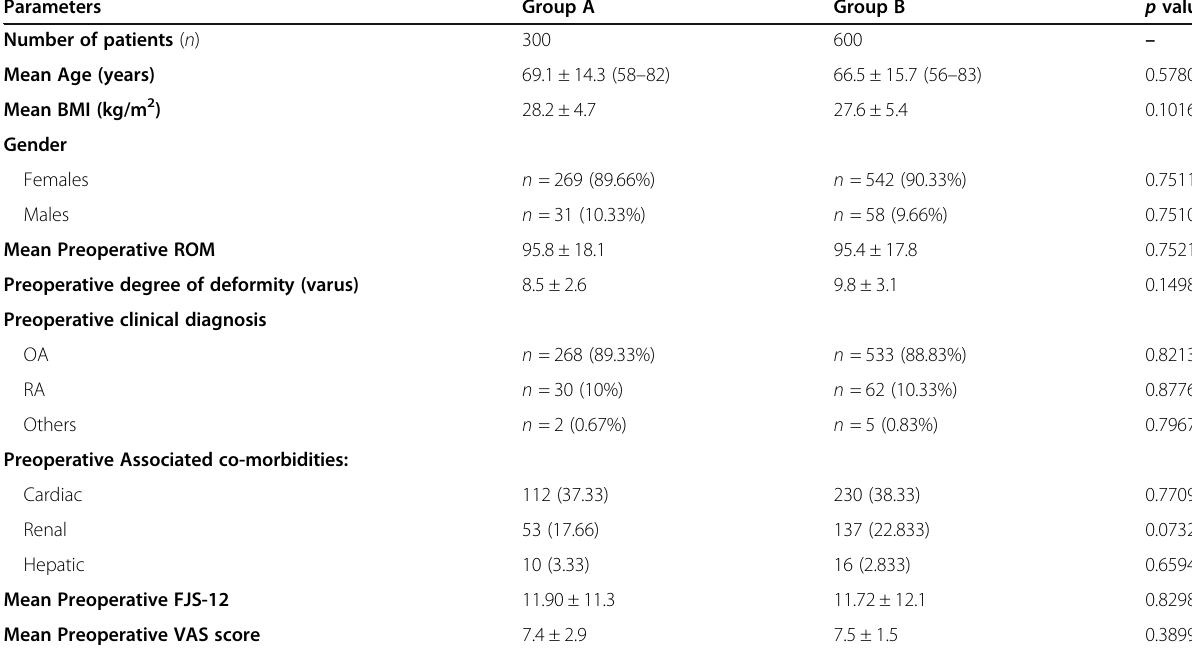
Table 1 Comparison of preoperative characteristics of patients between Group A and Group B